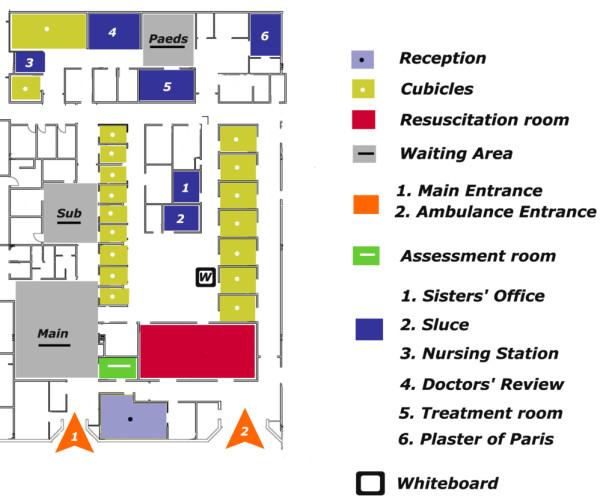
Old layout of ED.